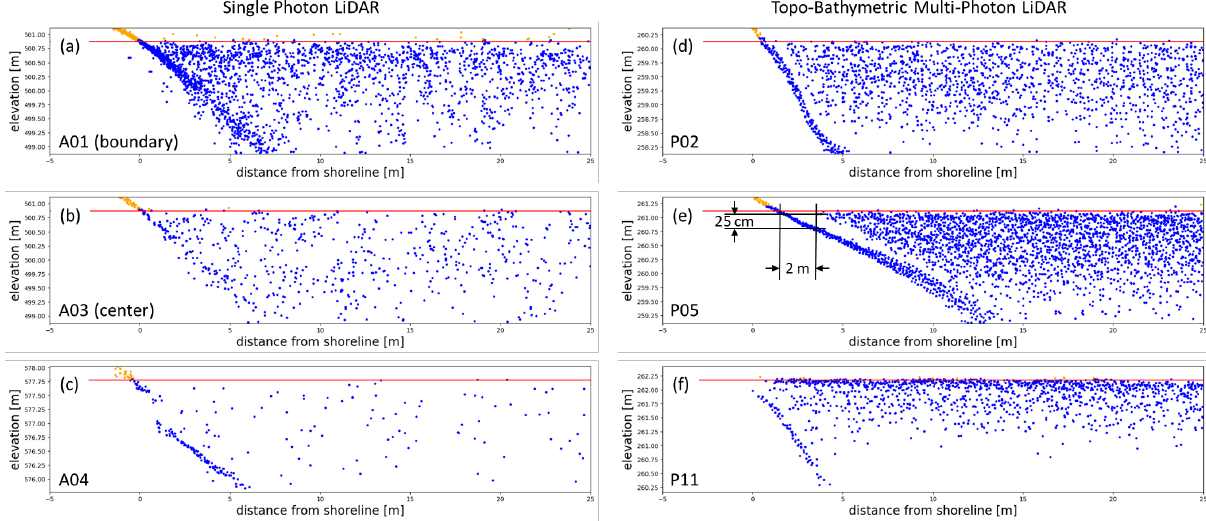
Figure 5. Selected vertical sections; (a-c) Single Photon LiDAR; (d-f) Topo-Bathymetric Multi-Photon LiDAR; blue: water candidate points, orange: points on dry land, red line: estimated water level